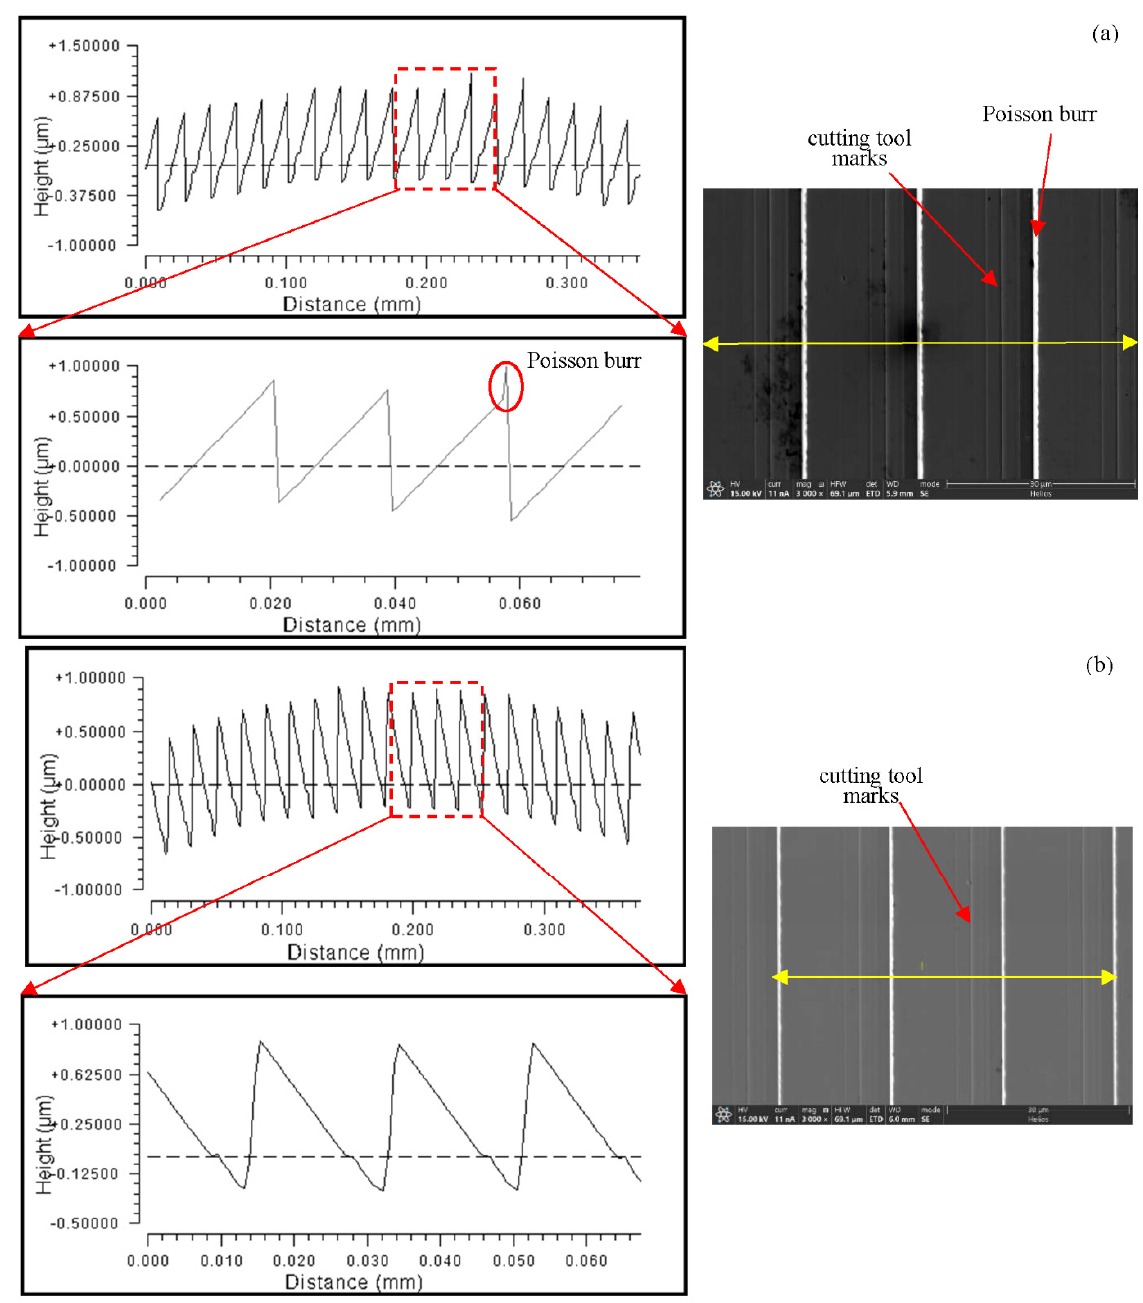
Figure 15. Comparison of Poisson burrs on the top of the grating for different workpiece materials along the equal-along-projection layout. ( a ) RSA6061 ( b ) RSA6061+ chemically plated NiP.